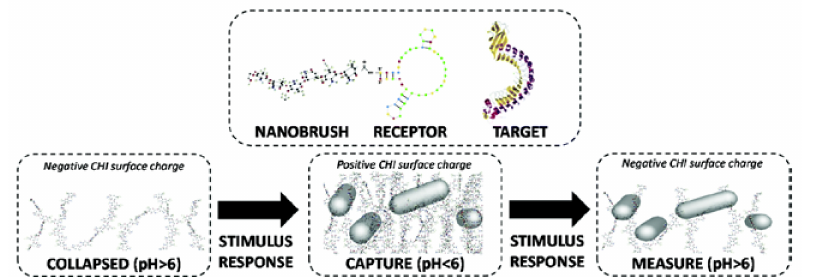
Figure 6. Nanobrush sensing strategy for selective bacteria capture. ( Top ) CHI-based nanobrushes are decorated with receptors, binding a cell target. ( Bottom ) Nanobrush is actuated from collapsed to extended states based on pH changes. The nanobrush is first extended (pH < 6), for cell capturing through a combination of electrostatic interactions and receptor–target binding, and then measure- ment (sensing) is conducted in the collapsed nanobrush state (pH > 6). Reprinted with the permission from reference [88]. Copyright 2018 Royal Society of Chemistry